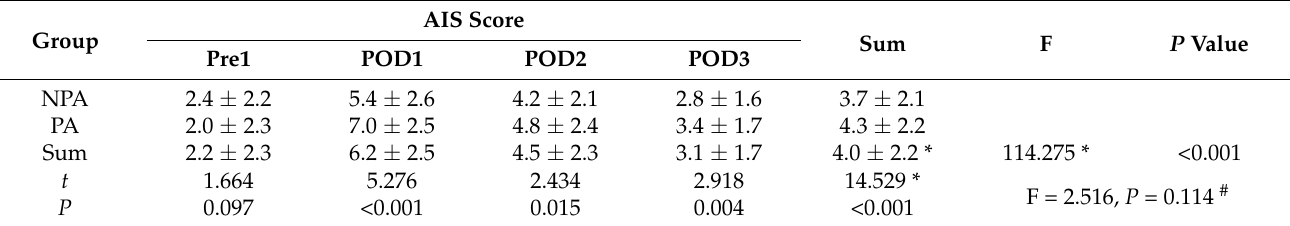
Table 2. Impacts of preoperative anxiety on postoperative sleep quality.